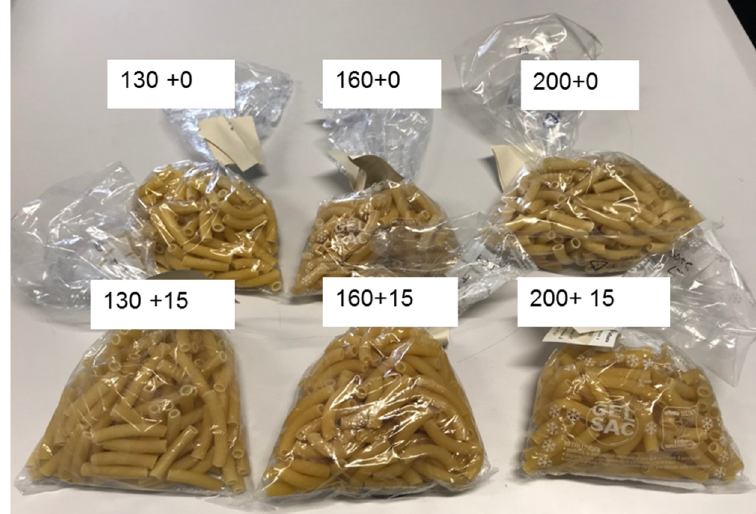
Figure 2. Site-specific pasta manufactured in the management zones.